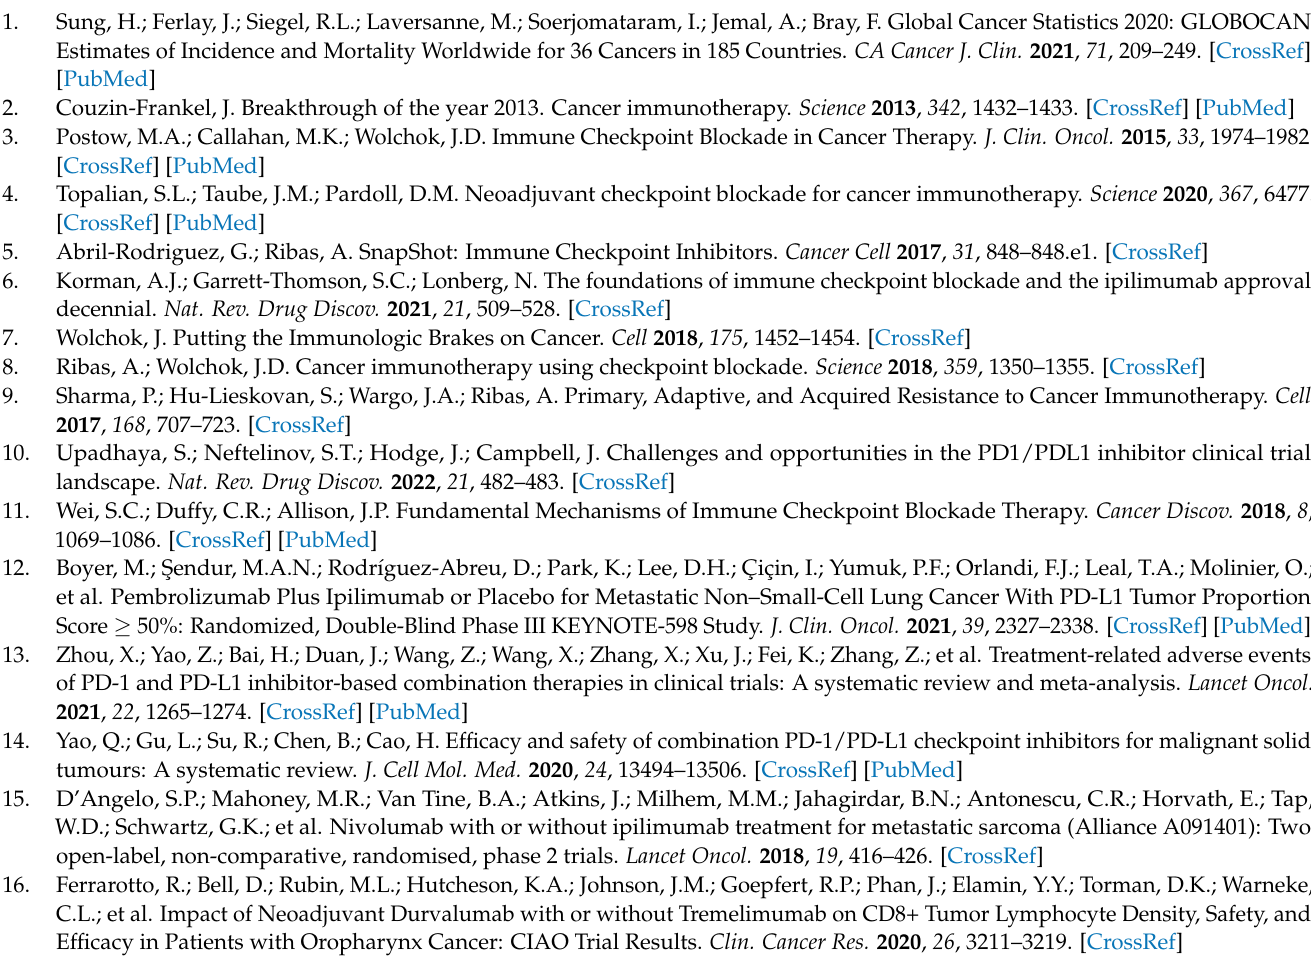
Figure S11: Begg’s test and Egger’s test (A)Begg’s test ( P = 0.803) and Egger’s test ( P = 0.860)